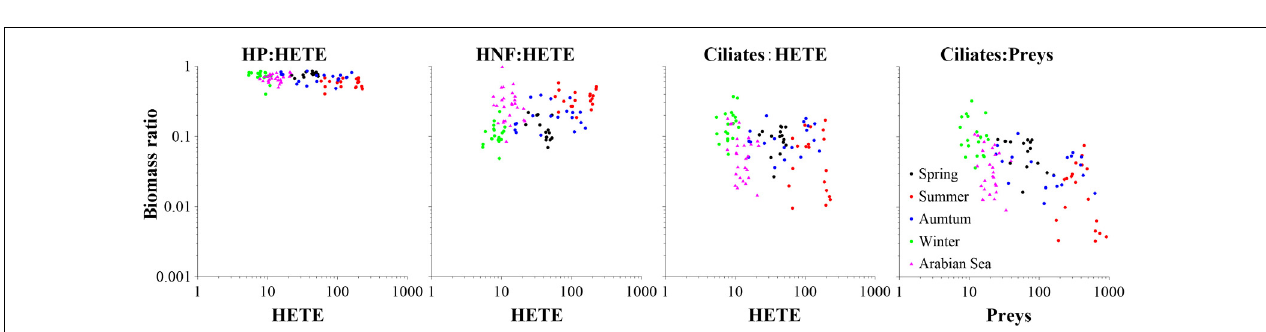
FIGURE 7 | Biomass ratio variations of HP, HNF and ciliates to HETE with the increase of HETE biomass ( µ g C dm − 3 ), and biomass ratio of ciliates to preys with the increase of prey biomass in Sanggou Bay and Arabian Sea. The data of Arabian Sea were extracted from Garrison et al. (2000). HP, heterotrophic prokaryotes; HNF, heterotrophic nanoflagellates; HETE, heterotrophic organisms.